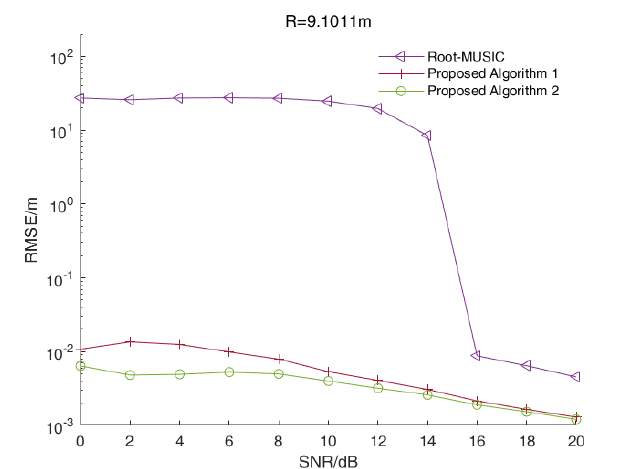
Figure 4. The RMSE values of the distance estimations versus the SNR values of all three algorithms when R = 8.6047 m.